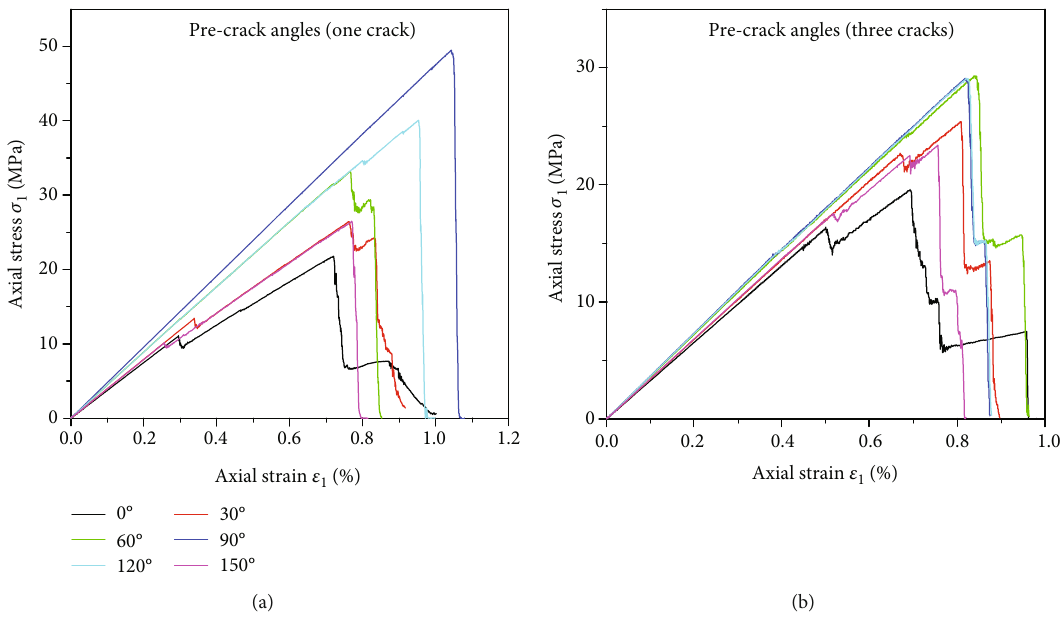
Figure 8: Complete stress-strain curves of the cracked specimens: (a) complete stress-strain curves of the specimens containing a single precrack; (b) complete stress-strain curves of the specimens containing three precracks.